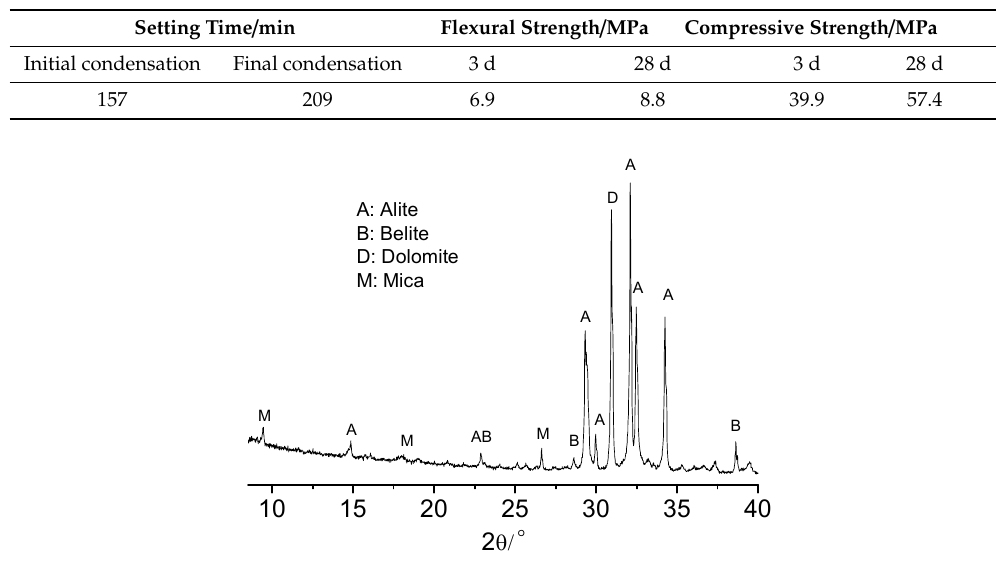
Table 2. Physical and mechanical properties of P.W 52.5 cement.